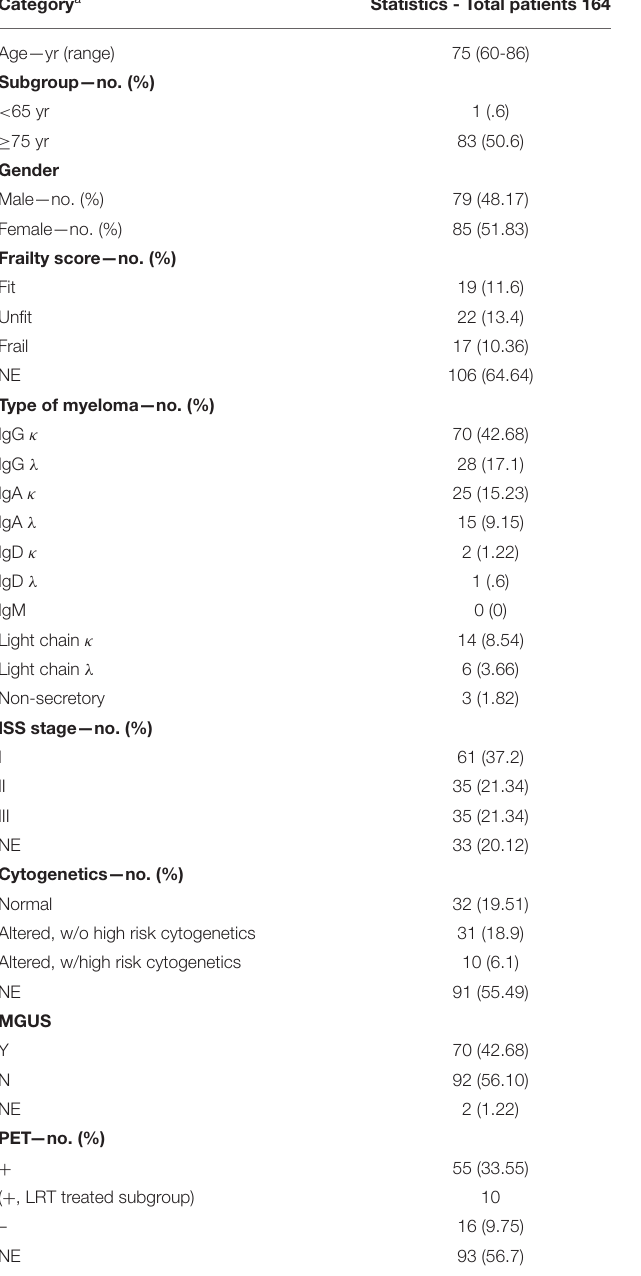
TABLE 1 | Patients’ baseline characteristics. Category a